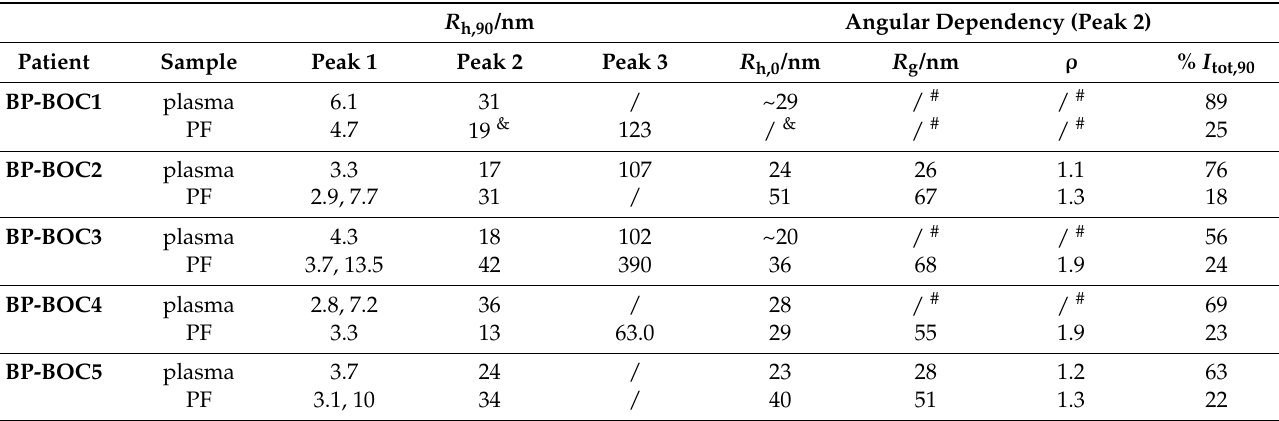
# analysis of the angular dependency was not possible; & this peak likely does not correspond to ENPs; PF = peritoneal